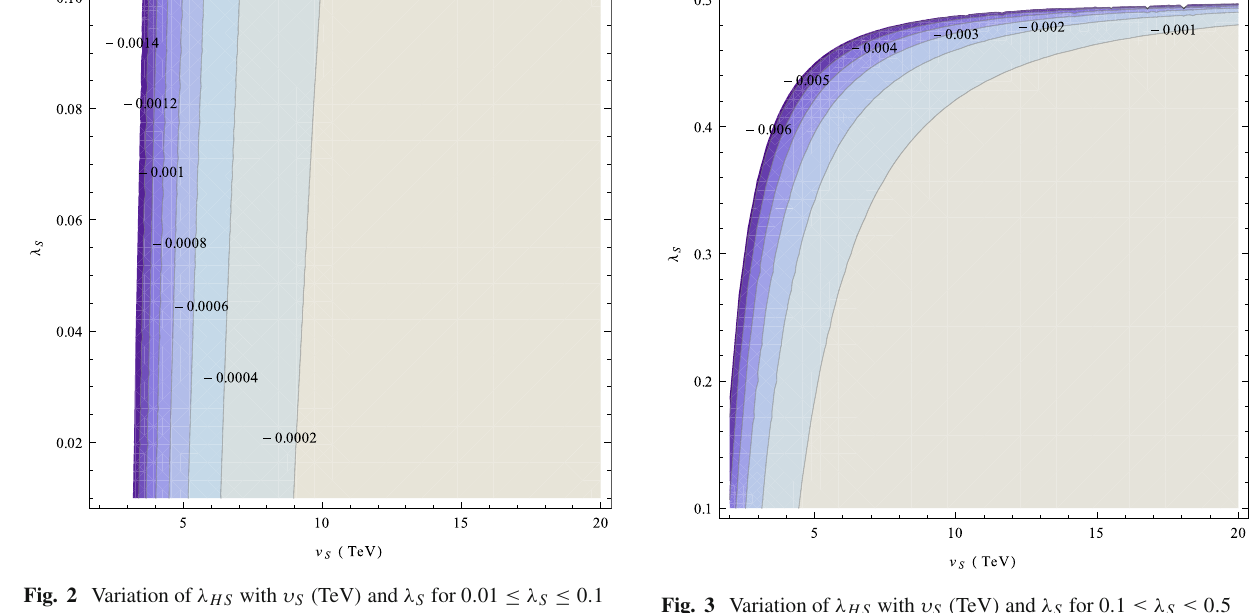
Fig. 3 Variation of λ HS with υ S ( TeV ) and λ S for 0 . 1 ≤ λ S ≤ 0 . 5